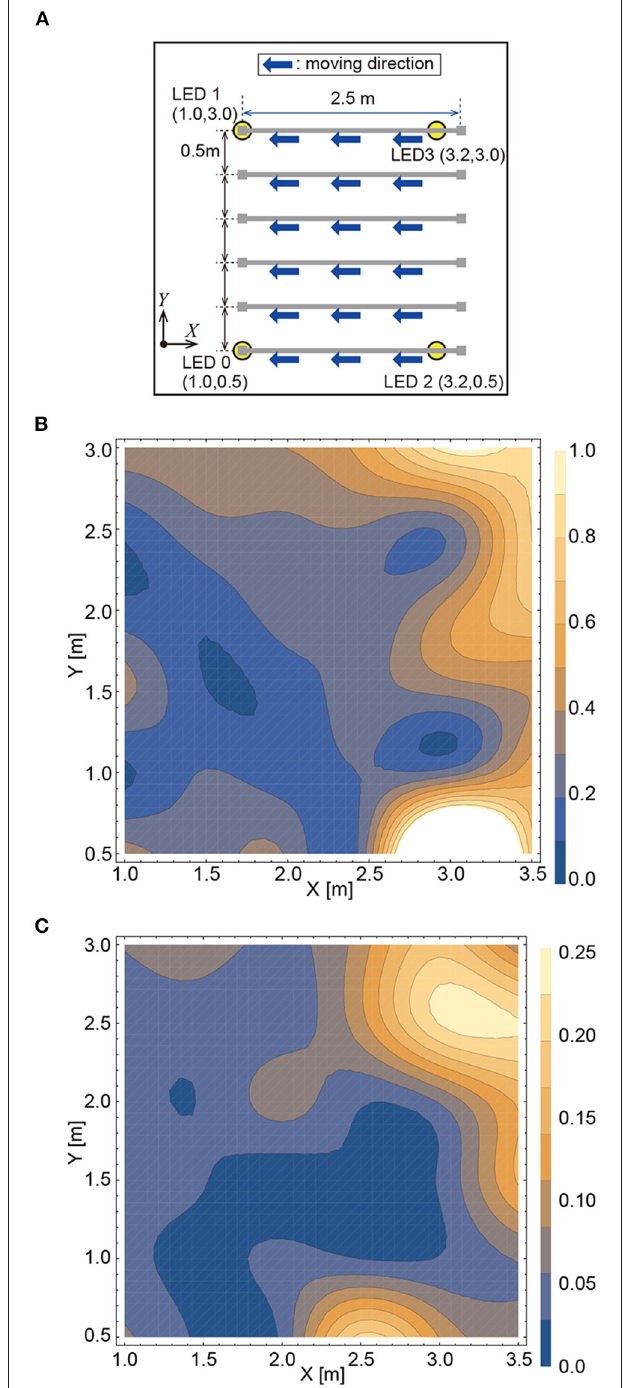
FIGURE 19 | Preliminary experiments in mobile environments: (A) experimental setting (B) heatmap representing absolute errors (C) heatmap representing standard